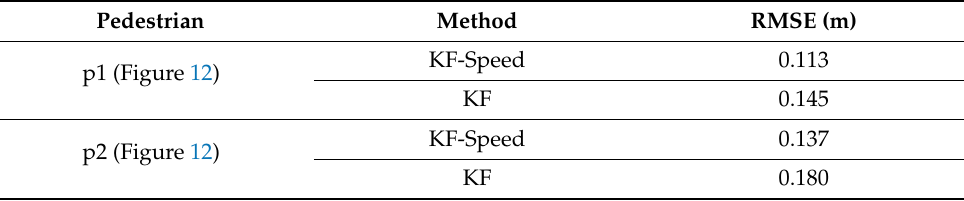
Table 9. RMSE between predicted locations and true